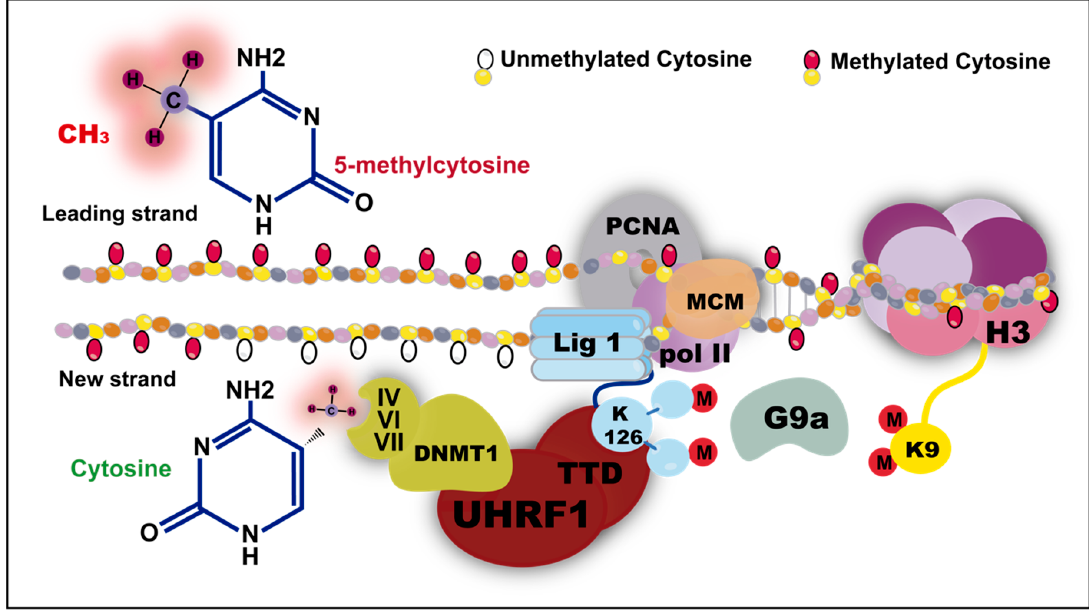
Figure 3. Recruitment of DNMT1 in maintenance methylation. During DNA replication in mammals, the information of the methylation patterns is copied faithfully from the template strand to the nascent strand. The protein complex for localization of DNMT1 is formed by PCNA, which is linked to ligase 1 (Lig 1). Di- or trimethylated ligase 1 in lysine 126 by G9a is tightly bound by the TTD domain of UHRF1, which is consequently linked to DNMT1. The interaction of motif VI of DNMT1 is important to stabilize the DNA–protein interaction. The IV domain of DNMT1 produces a nucleophilic attack on carbon 6, which causes a covalent bond that activates the carbon 5 atom towards the electrophilic attack, and the addition of the methyl group occurs. This is followed by the removal of 1 proton in carbon 5 and the resolution of the covalent interaction to result in the modification of cytosine to 5- methylcytosine.